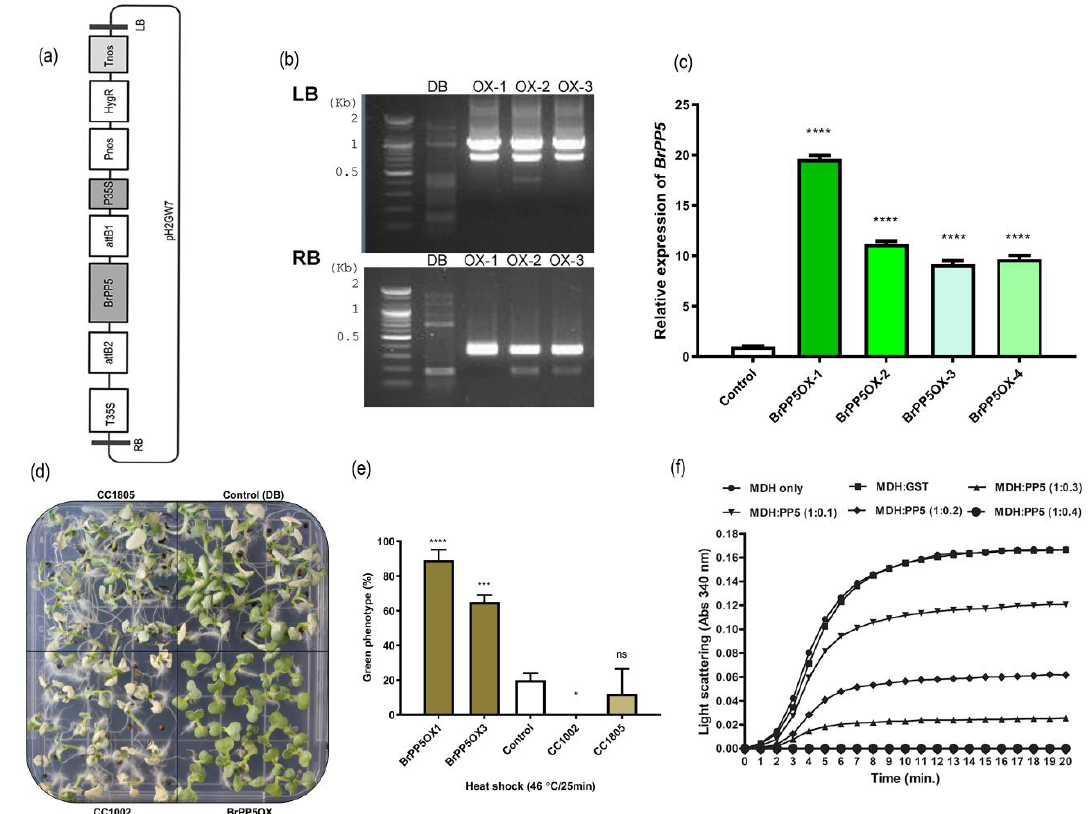
Figure 2. Development of BrPP5.2 overexpressing transgenic B. rapa lines and the phenotyping studies. ( a ) The simplified genetic expression cassette used for the overexpression of BrPP5.2 by Agrobacterium-mediated genetic transformation. ( b ) The results of T-DNA flanking sequencing of the selected transgenic lines confirming the transgenicity and identifying the transgene integration site in the host genome. ( c ) The transgene overexpression confirmation with non-transgenic control at the transcript level by a relative quantification method using qRT-PCR assay. BrACT2 was used for gene expression normalization. ( d , e ) The heat shock stress (at 46 ◦ C for 25 min) phenotyping of in vitro grown BrPP5.2 overexpressing transgenic lines (BrPP5OX) along with non-transgenic controls (DB) and heat-tolerant (CC1805) and heat-sensitive (CC1002) B. rapa cultivars ( d ) , while ( e ) represents the heat stress tolerance efficiencies of the respective test cultivars. ( f ) The graph illustrates the holdase type chaperone efficiencies of recombinant BrPP5.2 (provided at different molar ratios) in preventing heat stress (42 ◦ C) induced aggregation of a substrate, malate dehydrogenase (MDH), for 1–20 min. Ns = non-significant; * = p < 0.05; *** = p < 0.001; **** = p <